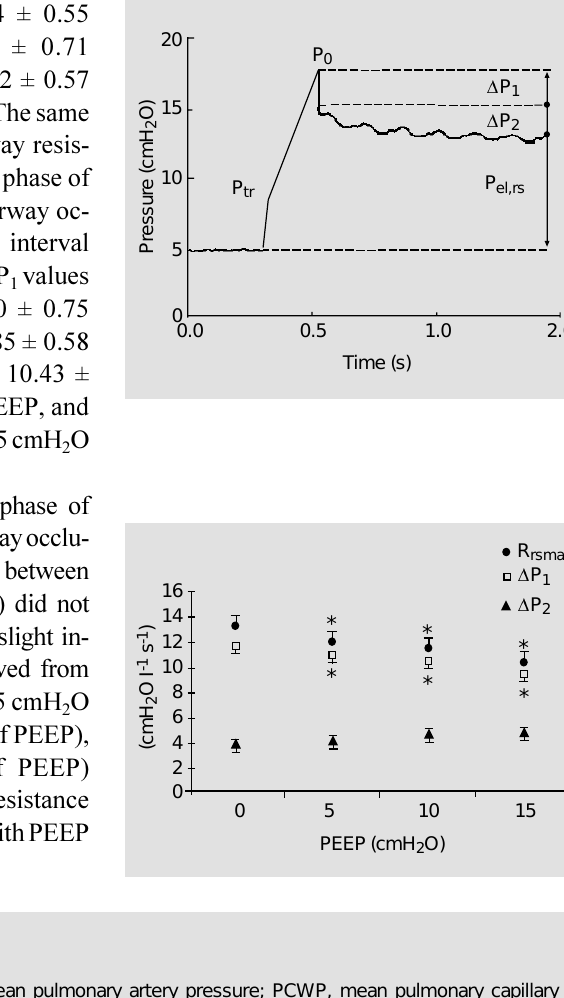
Figure 1 - Flow and pressure curves used for the evaluation of respiratory mechanical prop-